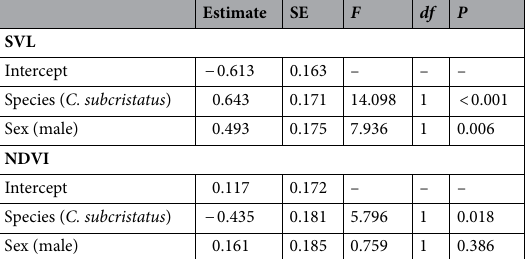
Table 2. Estimated coefficients for the two univariate linear models with SVL and NDVI, respectively, as response. The table shows the estimated model value (Estimate), standard error (SE), degrees of freedom ( df ), the F statistic and corresponding P -values ( p